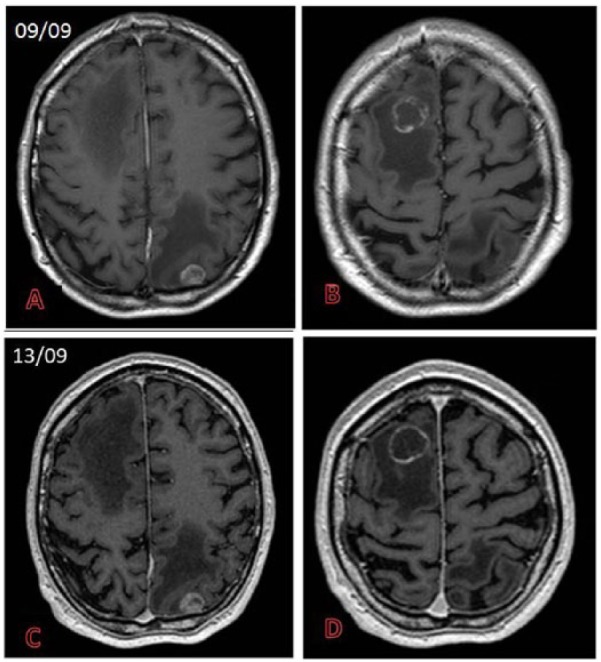
Multiple brain metastasis from lung cancer with ring-like enhancement and surrounding edema (A-D: postcontrast T1-weighted sequences) in the right frontal and left occipital lobes studied within an interval of 4 days (September 9 and September 13) with different contrast agents ( 13 mL of gadoterate meglumine in A and B and 6.5 mL of gadobutrol in C and D), with the same postcontrast delay. Better and more consistent enhancement seen in C and D due to the higher relaxivity of the contrast agent.